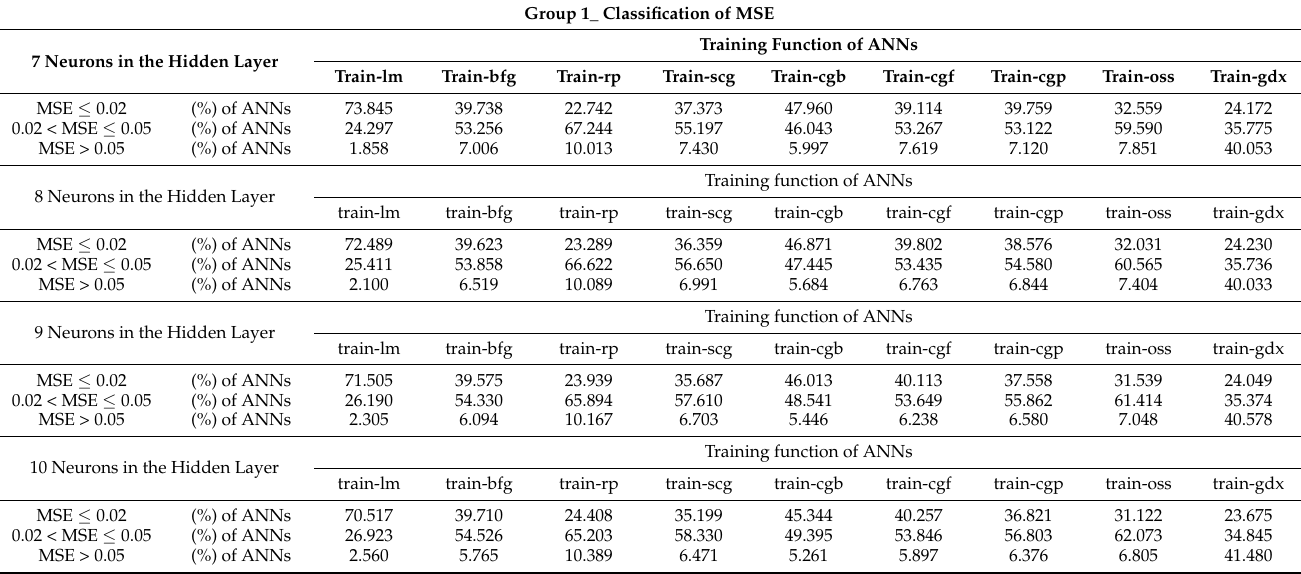
Table 9. Classification of MSE—ANNs with input parameters of Group 1.